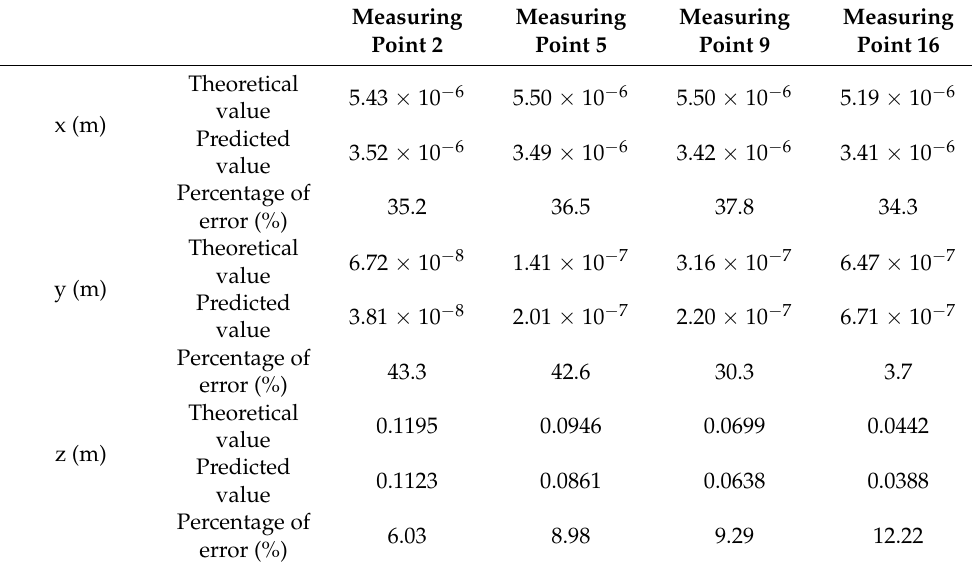
Table 4. Comparison of predicted and theoretical deformation variables.